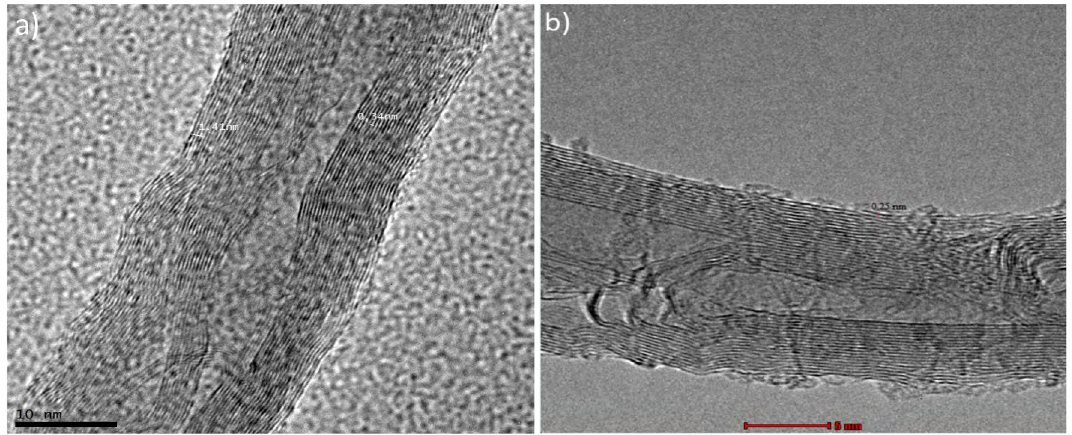
and MWCNTs in the ratio of 1:3 and b) HRTEM images of SiCNTs. 2